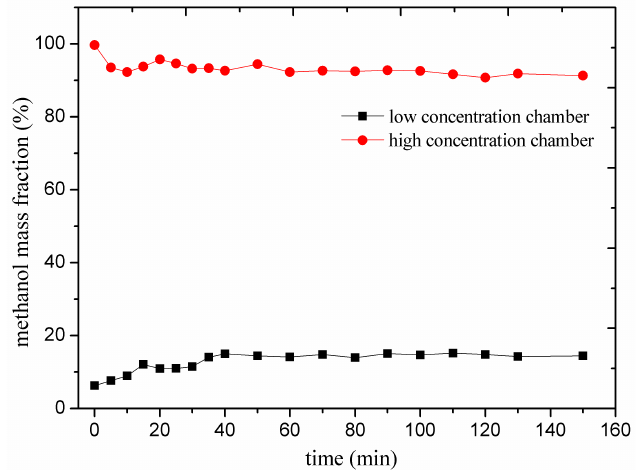
Figure 5. Methanol solution-time curves in the dual-chamber μ